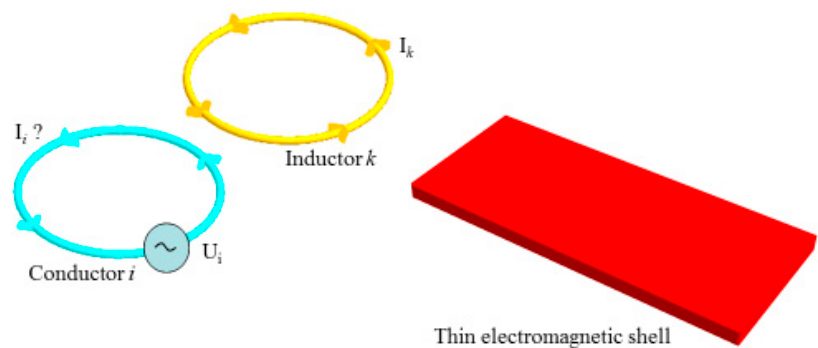
Figure 2. Representation of a general problem with conductors and thin electromagnetic shell.